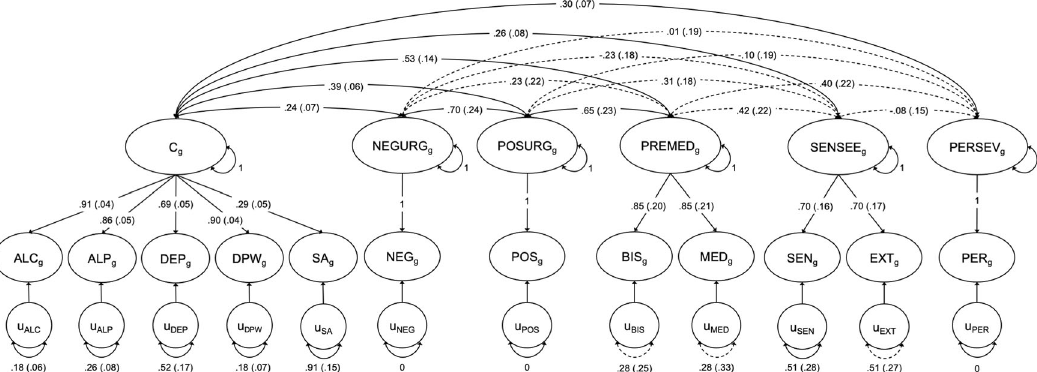
Fig. 2 Genetic associations between common liability for alcohol consumption, alcohol problems, and suicide attempt and impulsive personality traits. Parameter estimates were fully standardized; standard errors are shown in parentheses. Solid lines denote statistically signi fi cant paths ( p < 0.05) and fi xed paths. Dashed lines represent non-signi fi cant paths. For factors with only one indicator, factor loadings were fi xed to 1, and the residual variance of the indicator was fi xed to 0. Loadings were equated for factors with only two indicators.